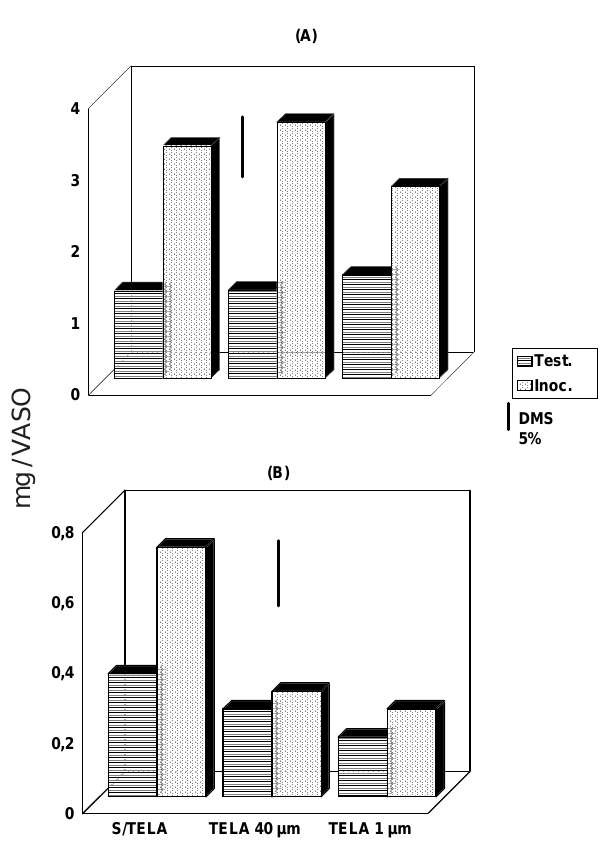
Figura 4. Conteúdo de fósforo (A) e 15 N (B) da parte aérea do milho, inoculado (Inoc.) ou não (Test.) com Glomus etunicatum , nos vasos com tela de 1 µm, 40 µm e sem